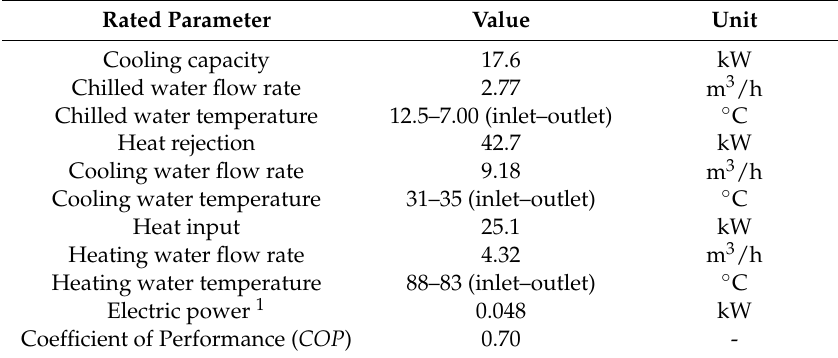
Table 7. AHP nominal